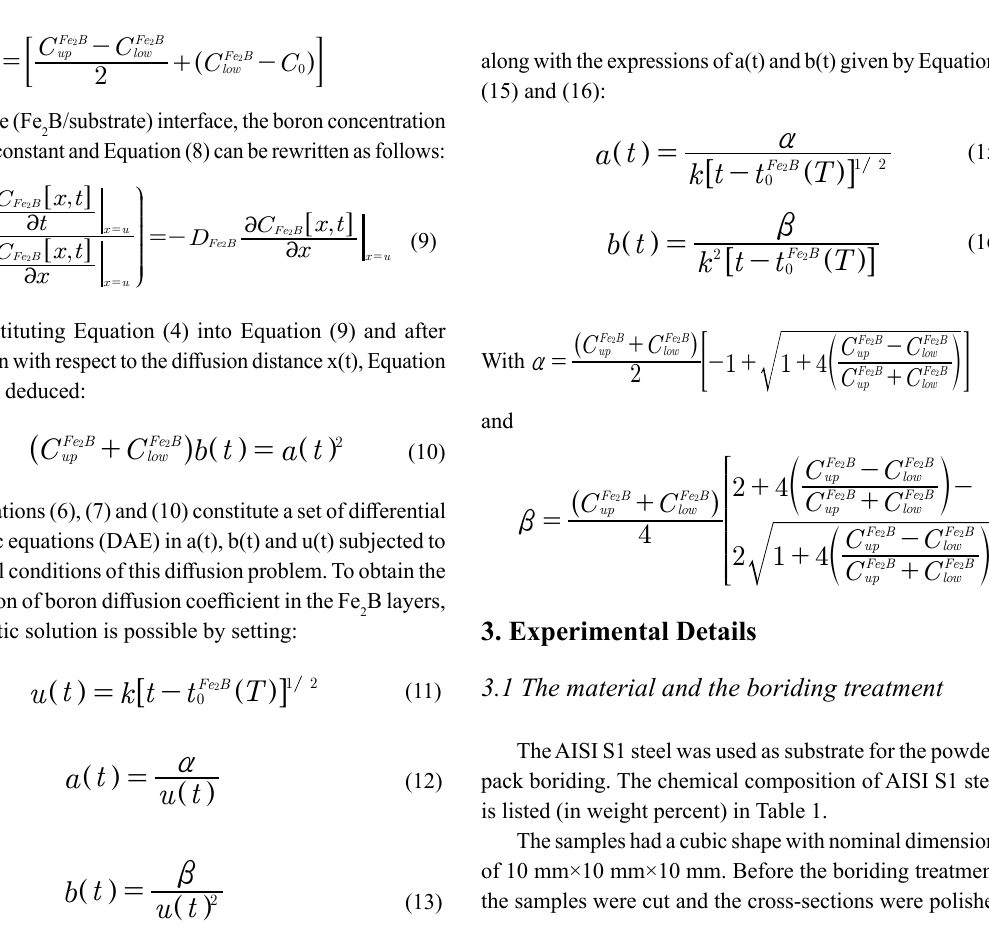
Table 1. The chemical composition of AISI S1 steel (in weight percent).